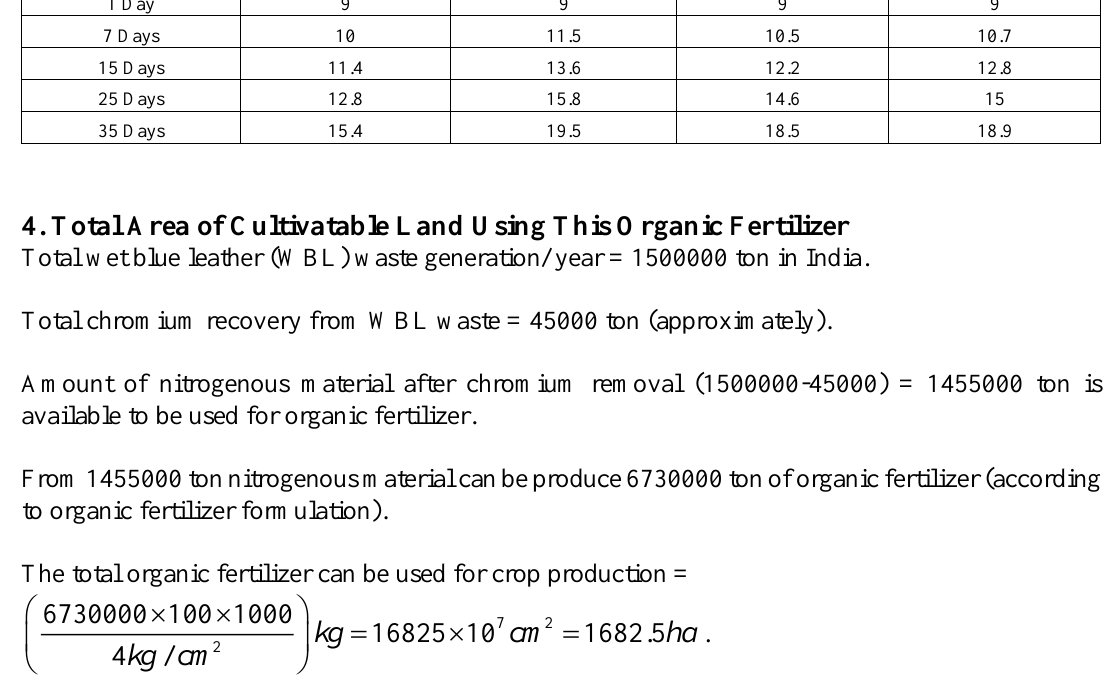
Figure 8. Effect of by different fertilizer on plant growth in terms of leaf size Table 1. Observation of plant growth (height) by different fertilizer Time Control (cm) Chemical fertilizer (cm) Type I fertilizer (cm) Type II fertilizer